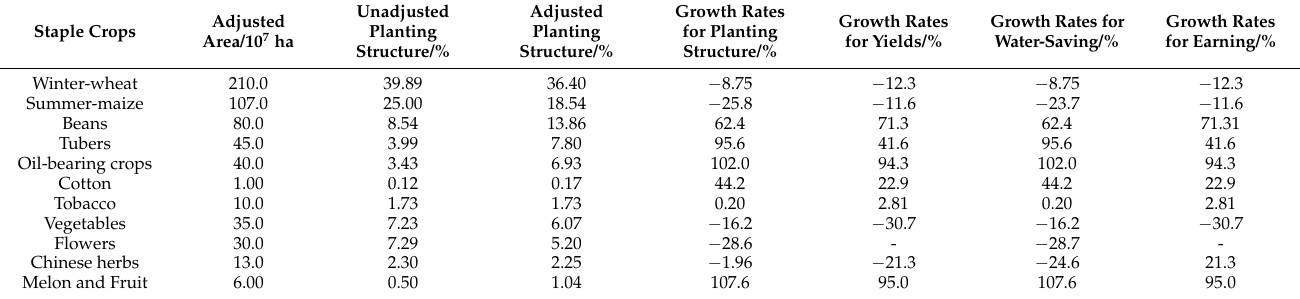
Table 4. Analysis of water-saving and economic benefits before and after planting structure adjustment. Staple